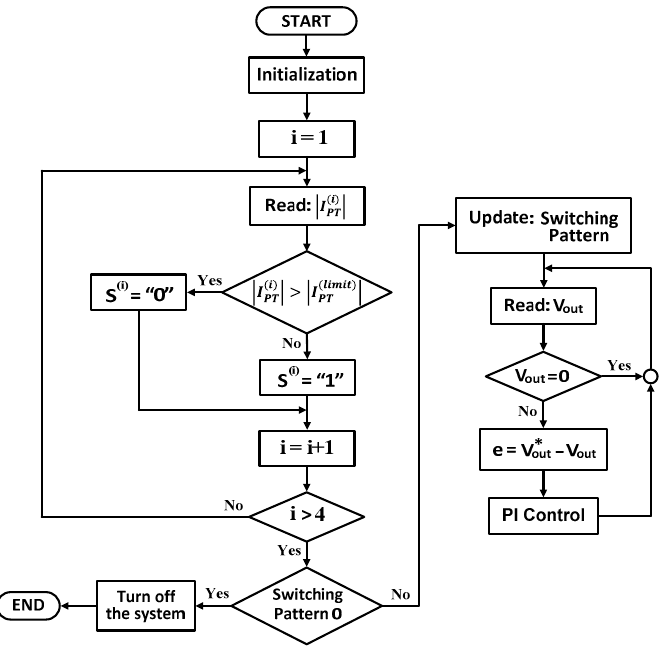
Figure 14. Proposed control block diagram of the primary-side controller: ( a ) Transmitter coil pattern selection mode; ( b ) Output voltage regulation mode.